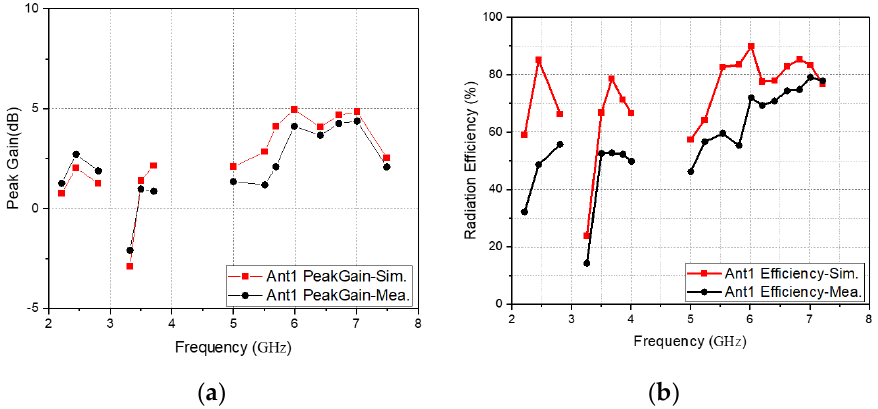
Figure 18. ( a ) Simulated and measured gain values of Ant. 1, ( b ) simulated and measured efficiency values of Ant. 1.